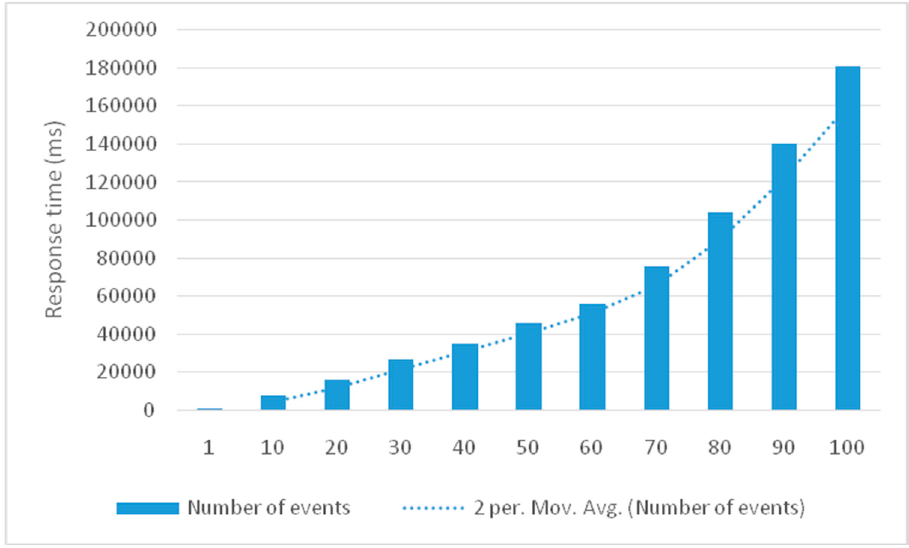
Figure 26. Response time of the approach. (per. Mov. Av: per Moving Average).